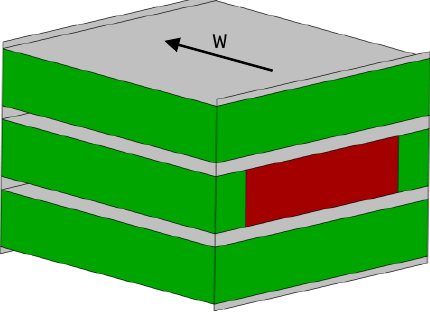
Fig. 6. Segment model with fin and louvres and sensor area simplified by porous zone.